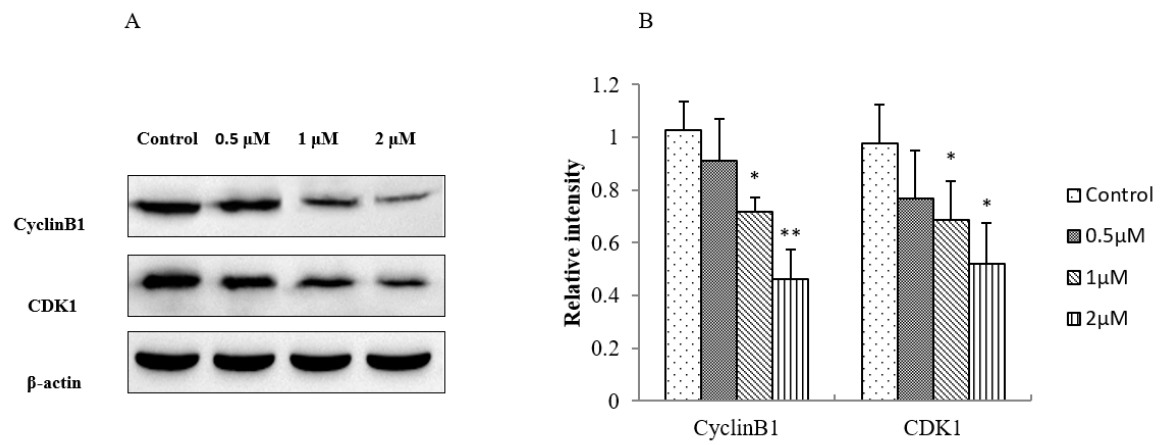
Figure 5. Western blot analysis of protein extracts obtained from H8 cells treated with 0, 0.5, 1, and 2 µ mol/L AO. ( A ) Western blot analysis of CyclinB1 and CDK1 expression in H8 cells treated with 0, 0.5, 1, and 2 µ mol/L AO. ( B ) Relative intensity values of CyclinB1 and CDK1 normalized by β -actin; (* p < 0.05, ** p < 0.01). SAA/OSR = 1:2 abbreviated as AO, which expressed the concentration of SAA as the concentration of AO, for example, 1 µ M AO is 1 µ M SAA plus 2 µ M OSR.